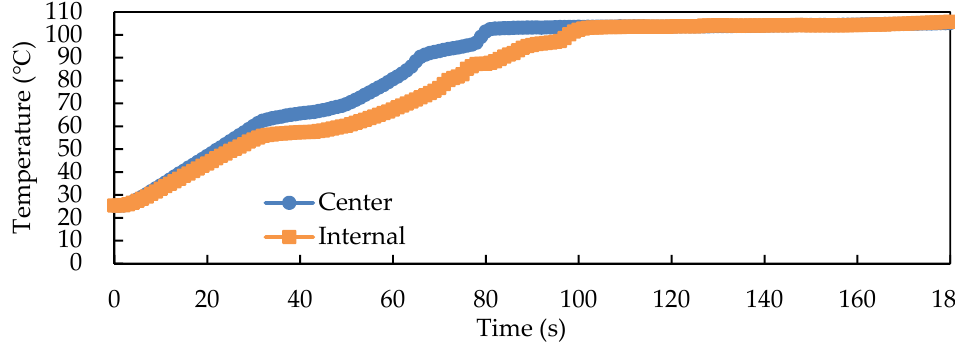
Figure 8. Average temperature profile and drying curve of the solid-state fermented W. cocos products during RF drying with an electrode gap of 15 cm. Data are expressed as the mean ± SD ( n = 3). If the solid-state fermented W. cocos product was used for continuous RF pasteurization and drying treatment, the temperature rising time during the drying process would be reduced by 50 s, thereby reducing the time required for the pasteurization and drying treatment of the fermented product to 180 s, which was extremely fast (Figure 9).